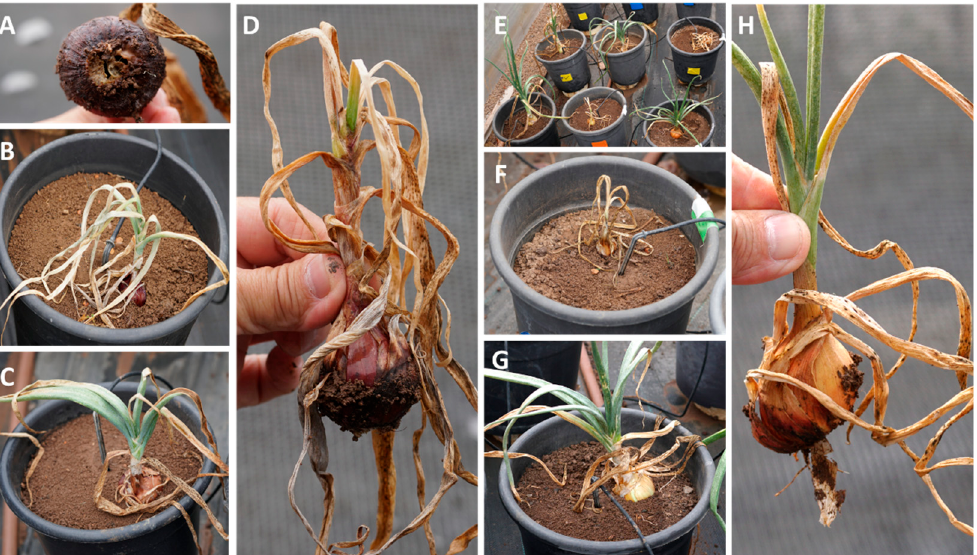
Figure 6. The experimental photos at the end of the season (day 115 from soil surface germination). The experiment is described in Figure 2. ( A – D ) onion Fusarium basal rot (FBR) disease symptoms in the red Noam cv. plants. ( E – G ) symptoms in the white Orlando cv. plants. ( E ) representative photo of the disease diversity among the different treatments. ( A , B , D , F , H ) severe disease, ( C , G ) mild disease.